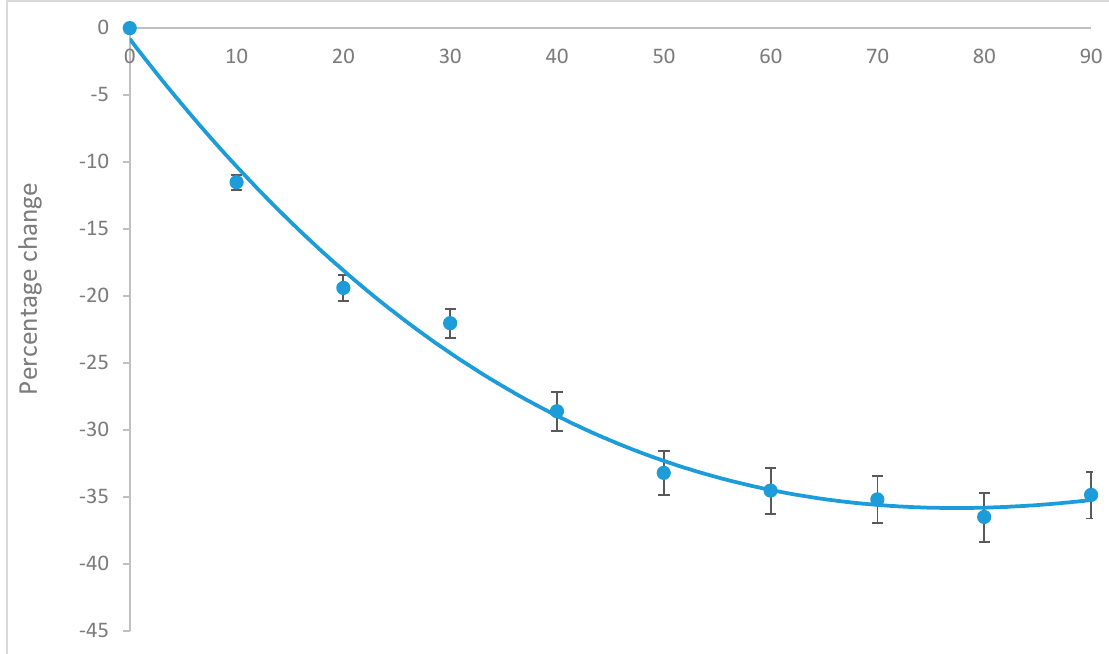
Figure 5. Time dependent auto-oxidation of reduced glutathione (GSH) with fold increase in oxidised glutathione (GSSG). 200 uM GSH was subjected to GSSG assay protocol at different incubation times. Samples were incubated at 4 °C for varying times, 40 mM NEM was added and incubated with O-